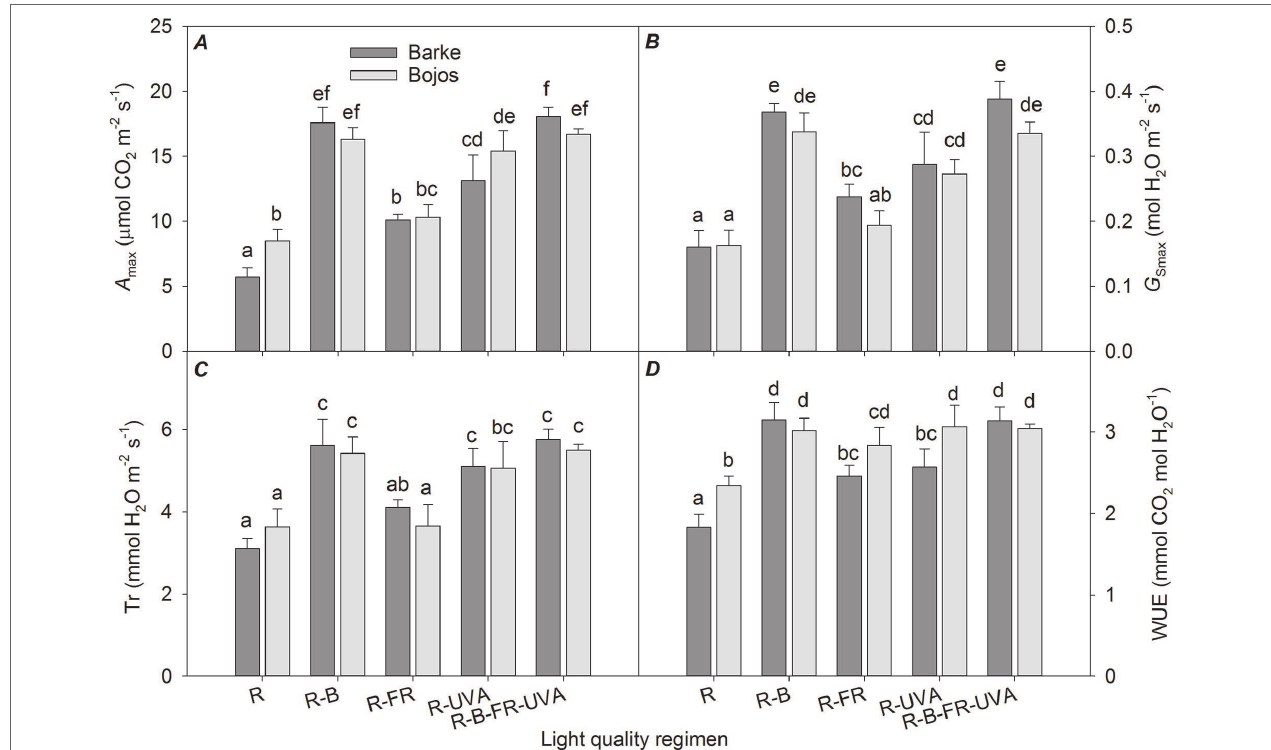
FIGURE 5 | Effect of 26 days exposure to different light regimens on light-saturated CO 2 assimilation rate ( A max , A ), light-saturated stomatal conductance ( G Smax , B ), transpiration rate (Tr, C ), and water use efficiency (WUE, D ) of spring barley varieties Barke (dark grey) and Bojos (light grey). Additional details are in the Figure 1 legend.